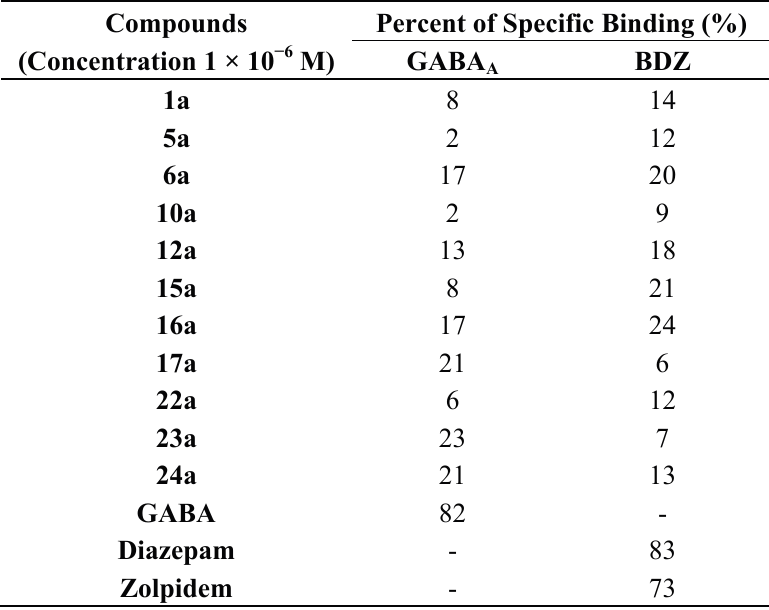
Table 4. Affinity of the selected 1,2,4-triazole derivatives to GABA benzodiazepine (BDZ)-binding sites.